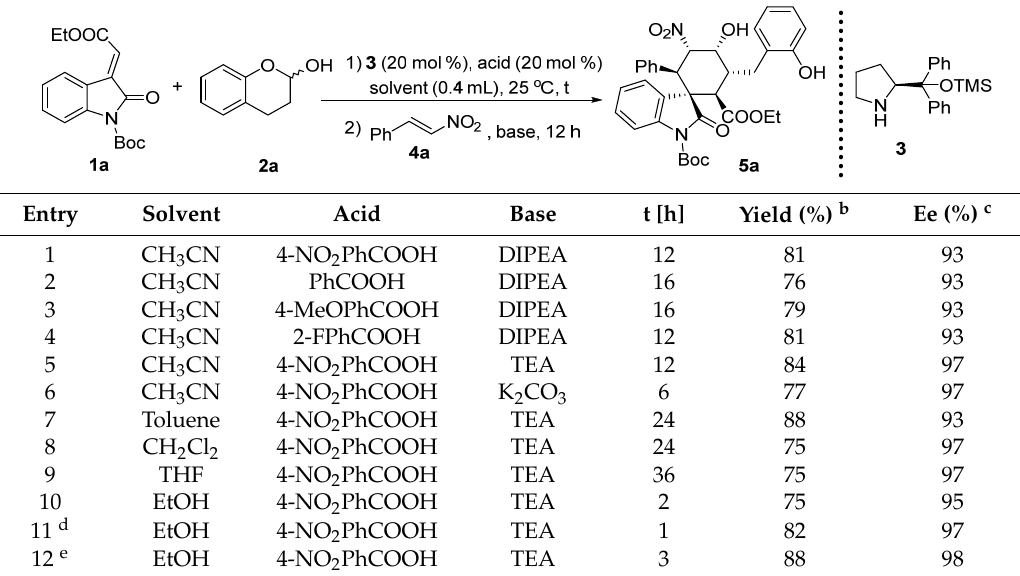
Table 1. Screening studies for the [2+2+2] annulation to synthesize six-membered carbocycles a .